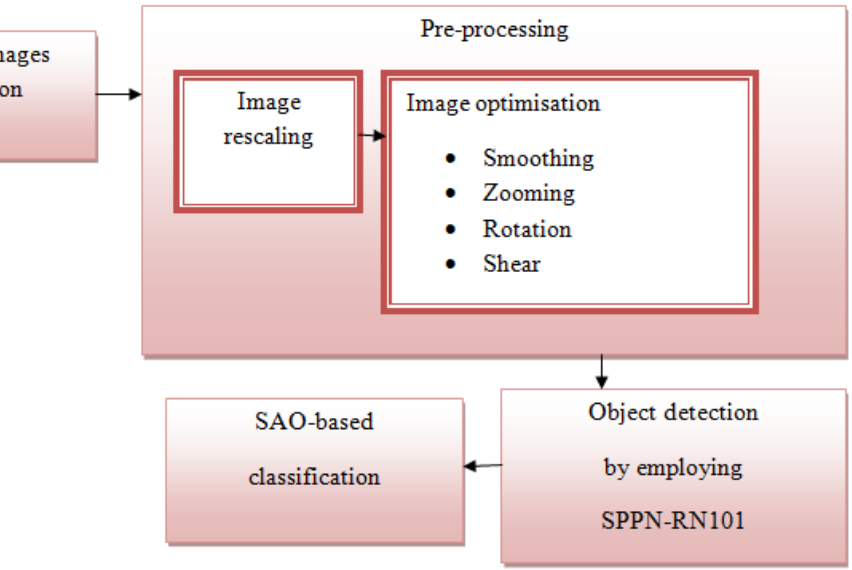
Figure 1. FOD’s comprehensive system framework.